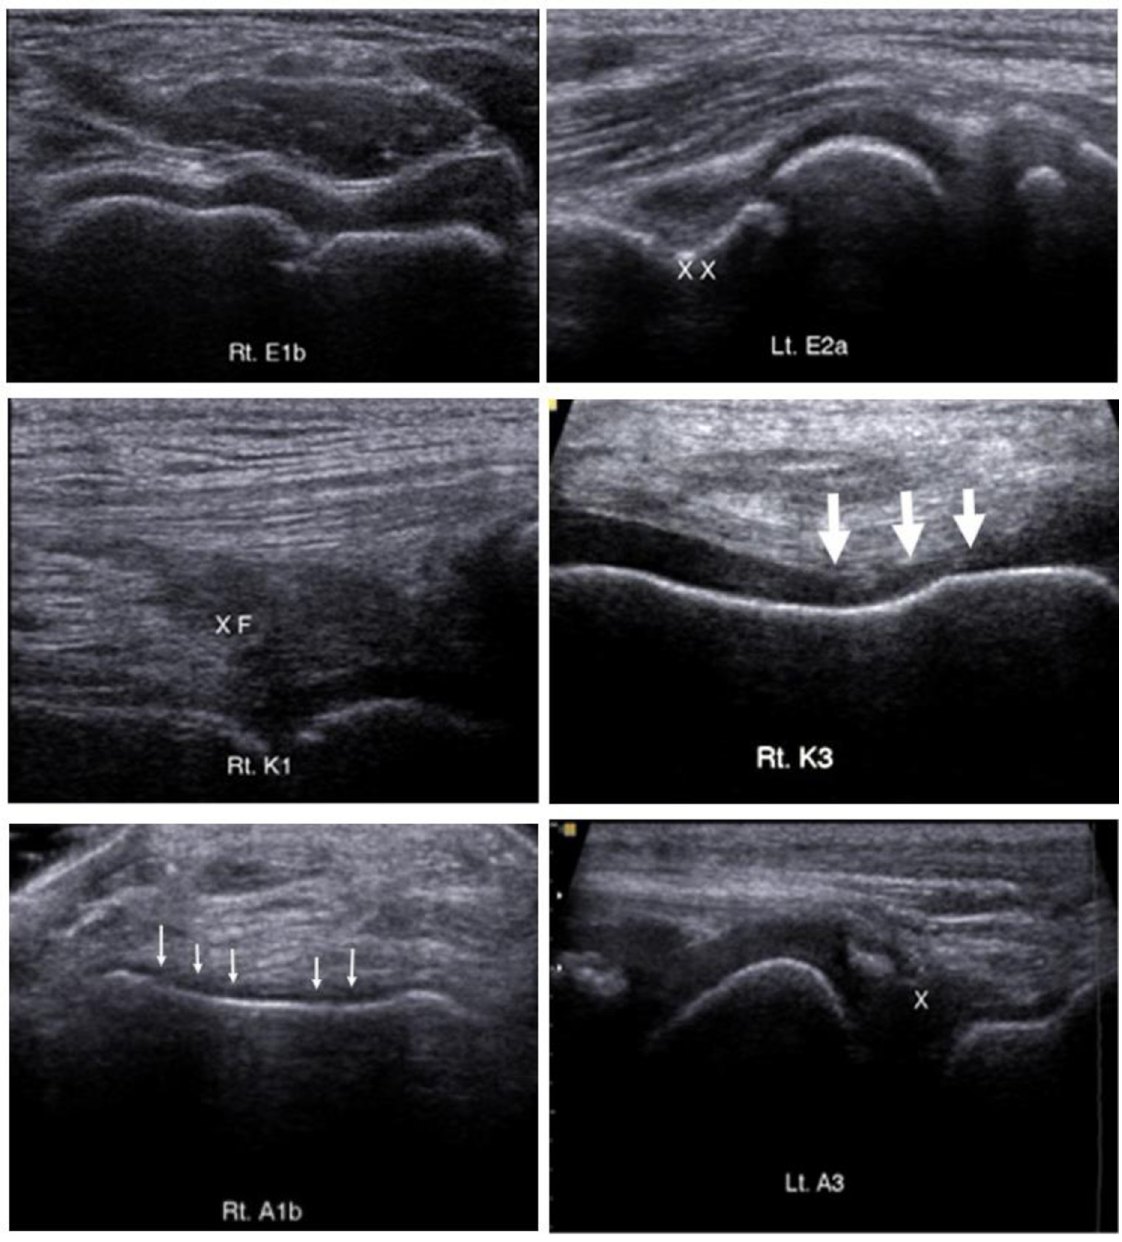
Fig 1. The example of HEAD-US appearance on different subjects: Elbow (E1b, E2a), knee (K1, K3), and ankle (A1b, A3). There is synovial hypertrophy of the anterior cubital fossa of the elbow (XX), the suprapatellar recess of the knee (XF) and the posterior of the subtalar joint (X). There is also cartilage irregularity and thinning at the femoral trochlea of the knee (large arrow) and talar dome of the ankle (small arrow).